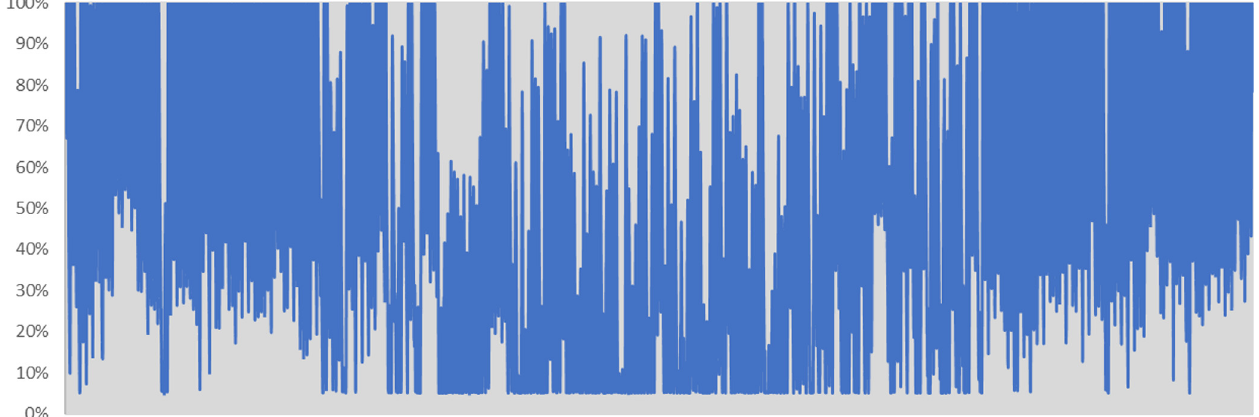
Fig. 4. DESS battery state of charge cycles over year 2016 – modelled